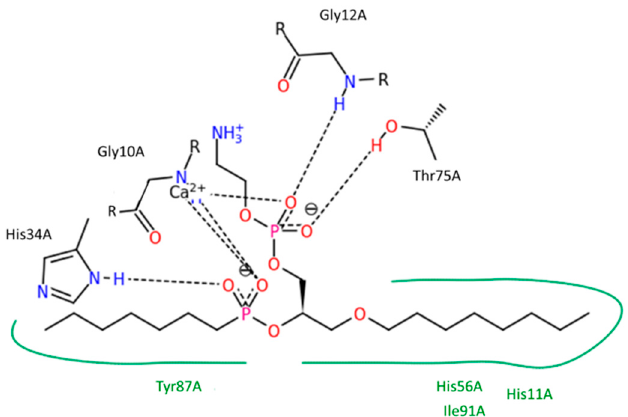
Figure 9. Binding pocket of bee venom PLA 2 with a transition state analog, phospholipid [45]. PoseView diagram: Black dashed lines indicate hydrogen bonds, salt bridges, and metal interactions. Green solid lines show hydrophobic interactions and green dashed lines show π – π and π -cation interactions. Interactions are determined by geometric criteria, as previously described [47] .